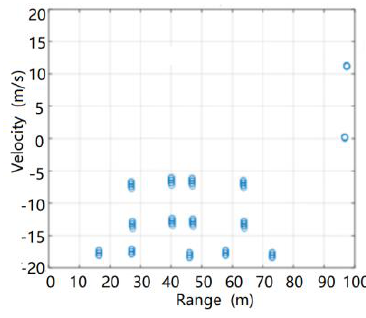
Figure 24. Target output of radar in highway scene with heavy rain.